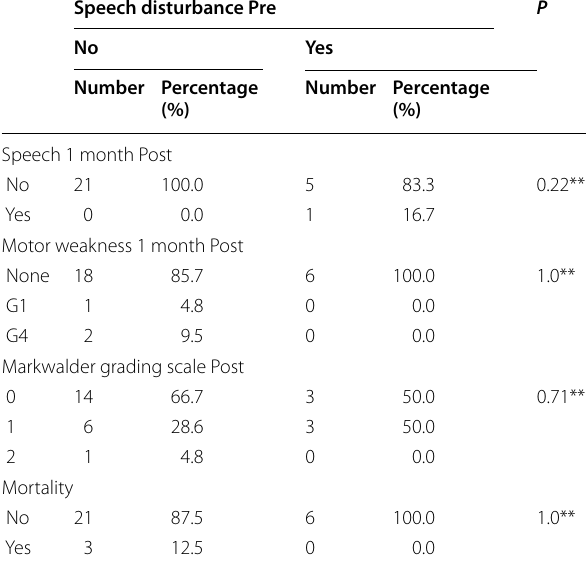
Table 11 Cases with and without preoperative speech disturbance compared regarding final study outcomes